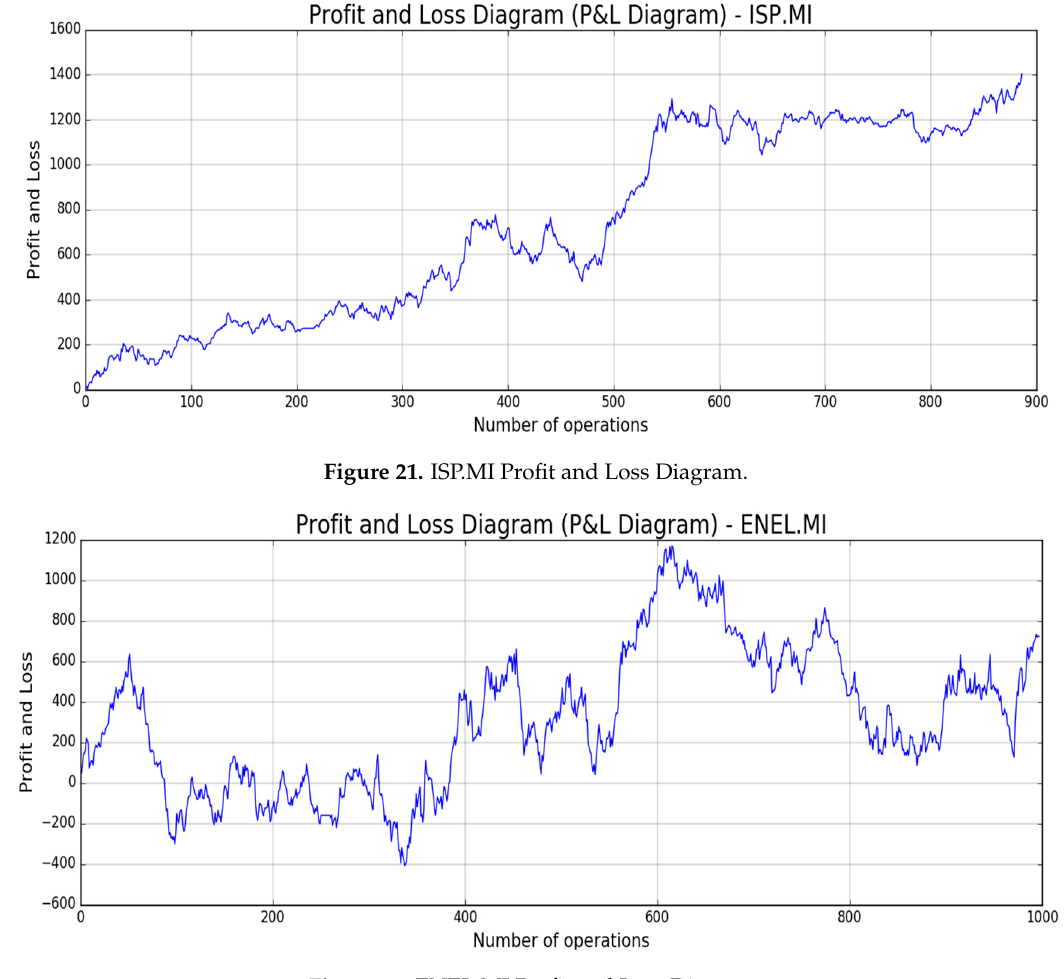
Figure 22. ENEL.MI Profit and Loss Diagram.